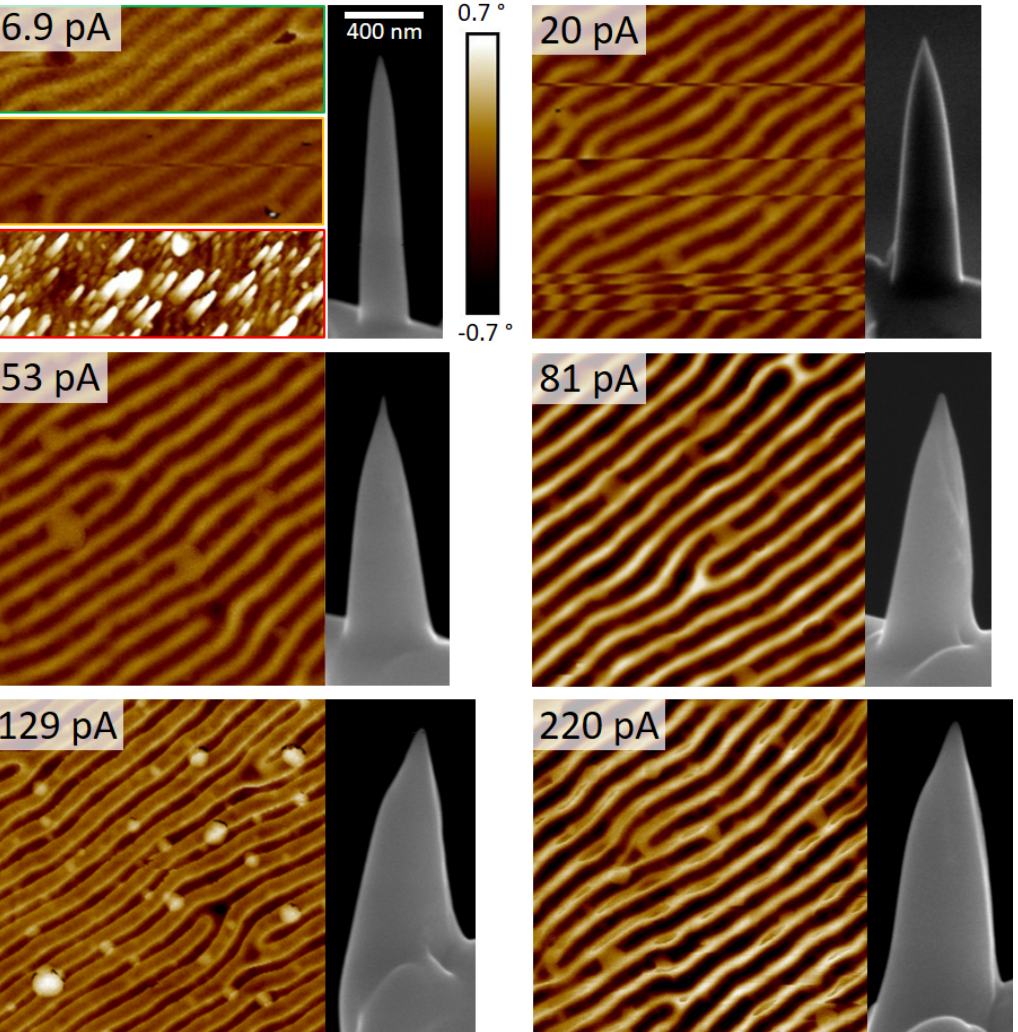
Figure 4. 2 × 2 µ m 2 wide MFM phase maps of the CoPt multilayer sample, imaged with α -pillars of similar heights, fabricated at 20 keV, while I 0 was varied from 6.9–220 pA. For lowest currents, the MFM performance was very unstable, as shown by three representative images on the top left. The right SEM images show the respective Co 3 Fe probes; the scale bar of 6.9 pA applies to all.